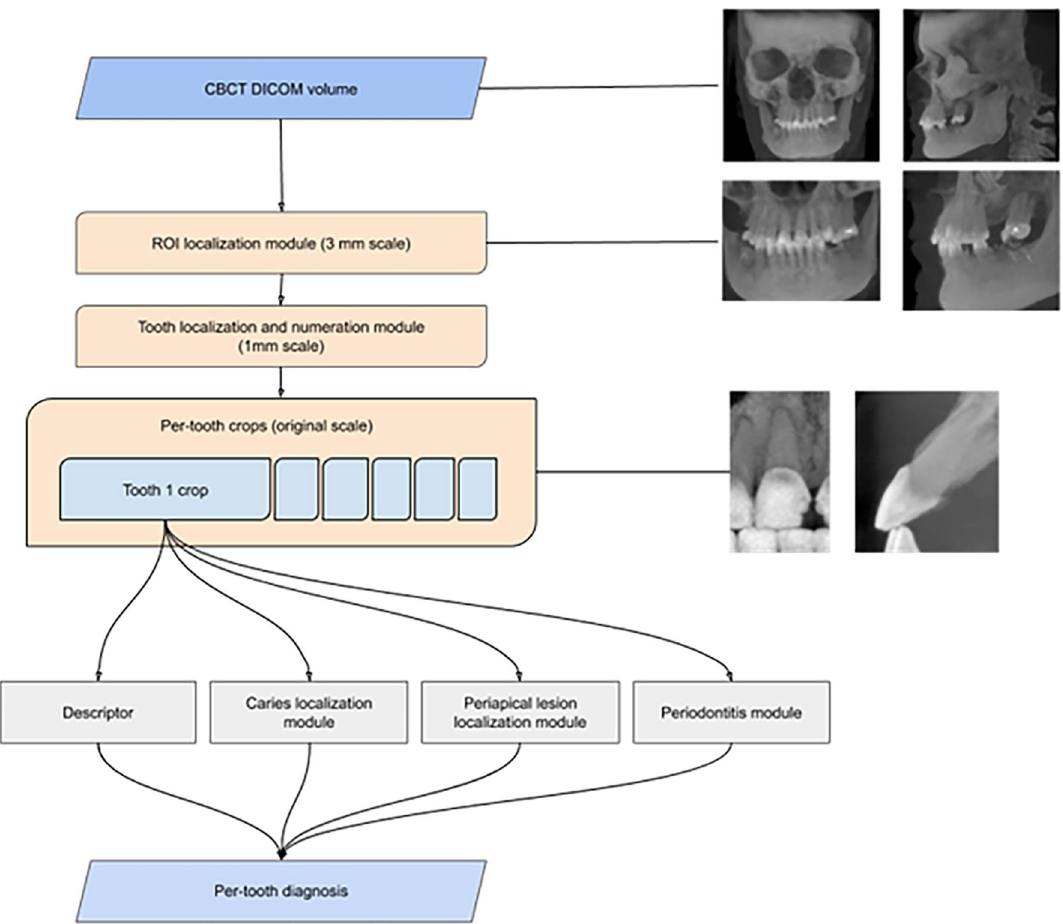
Figure 1. Flow diagram of CBCT processing pipeline and workflow of the AI